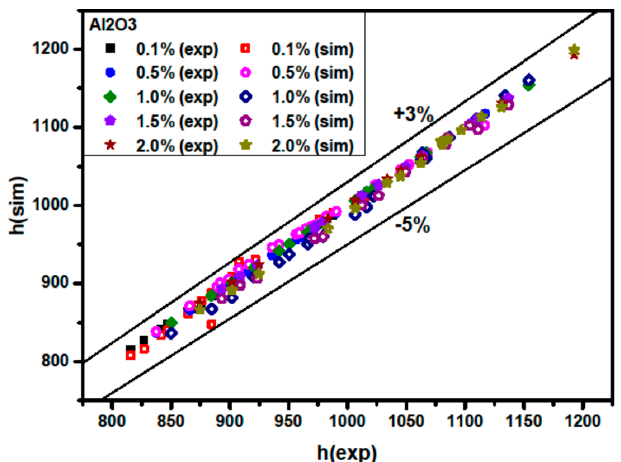
Figure 12. Comparison between numerically-predicted and experimentally-measured heat transfer coefficients at various particle volume concentrations and Pe values for Al 2 O 3 /water nanofluids.